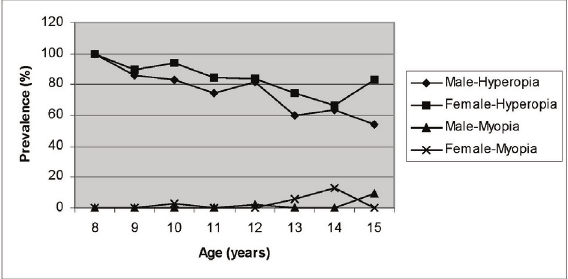
Figure 2 Graphical representation of the prevalence of refrac- tive powers by age in the right eyes of the male and female subjects. Hyperopia was more prevalent in both genders.